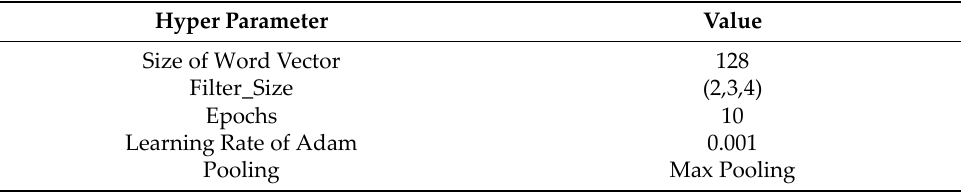
Table 1. TextCNN Channel model hyperparameter setting table.